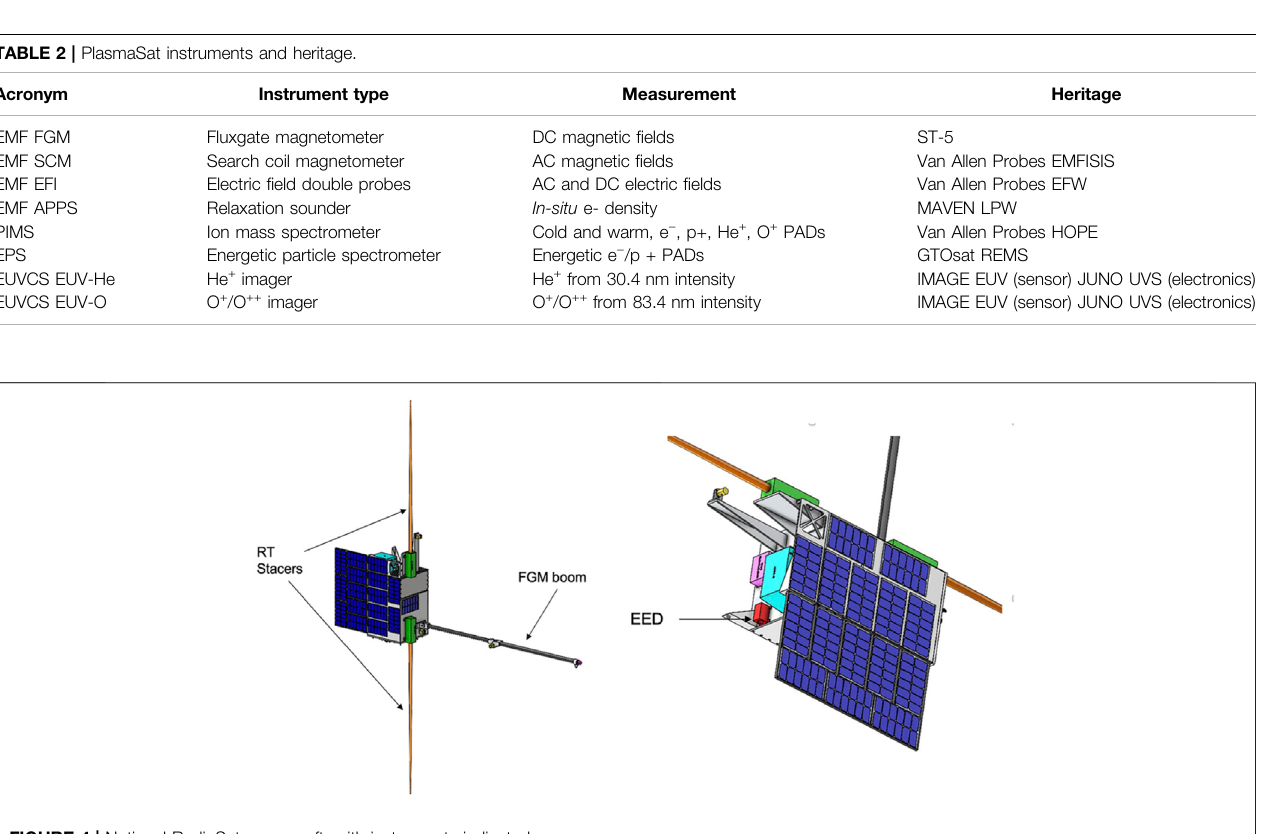
FIGURE 4 | Notional RadioSat spacecraft, with instruments